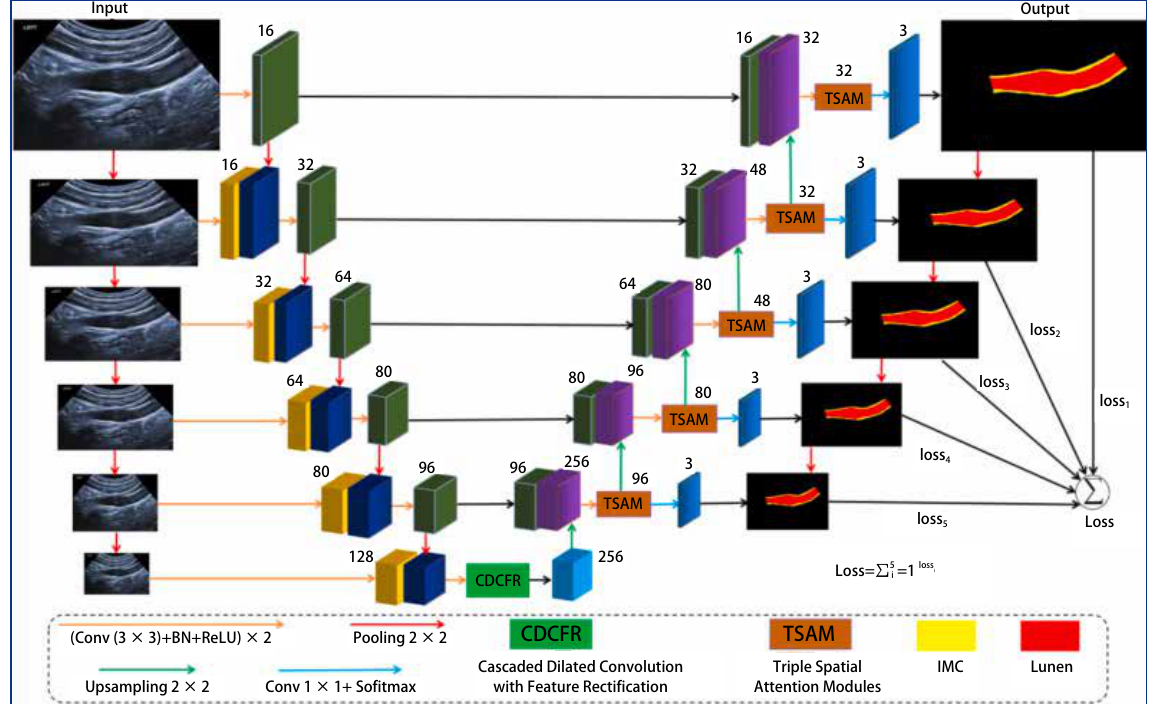
Figure 4 Network architecture of CSM-Net